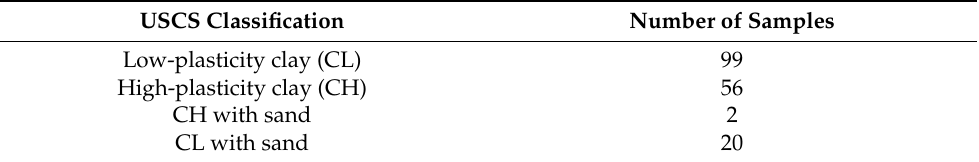
Table 1. List of the USCS classifications related to 177 texts.